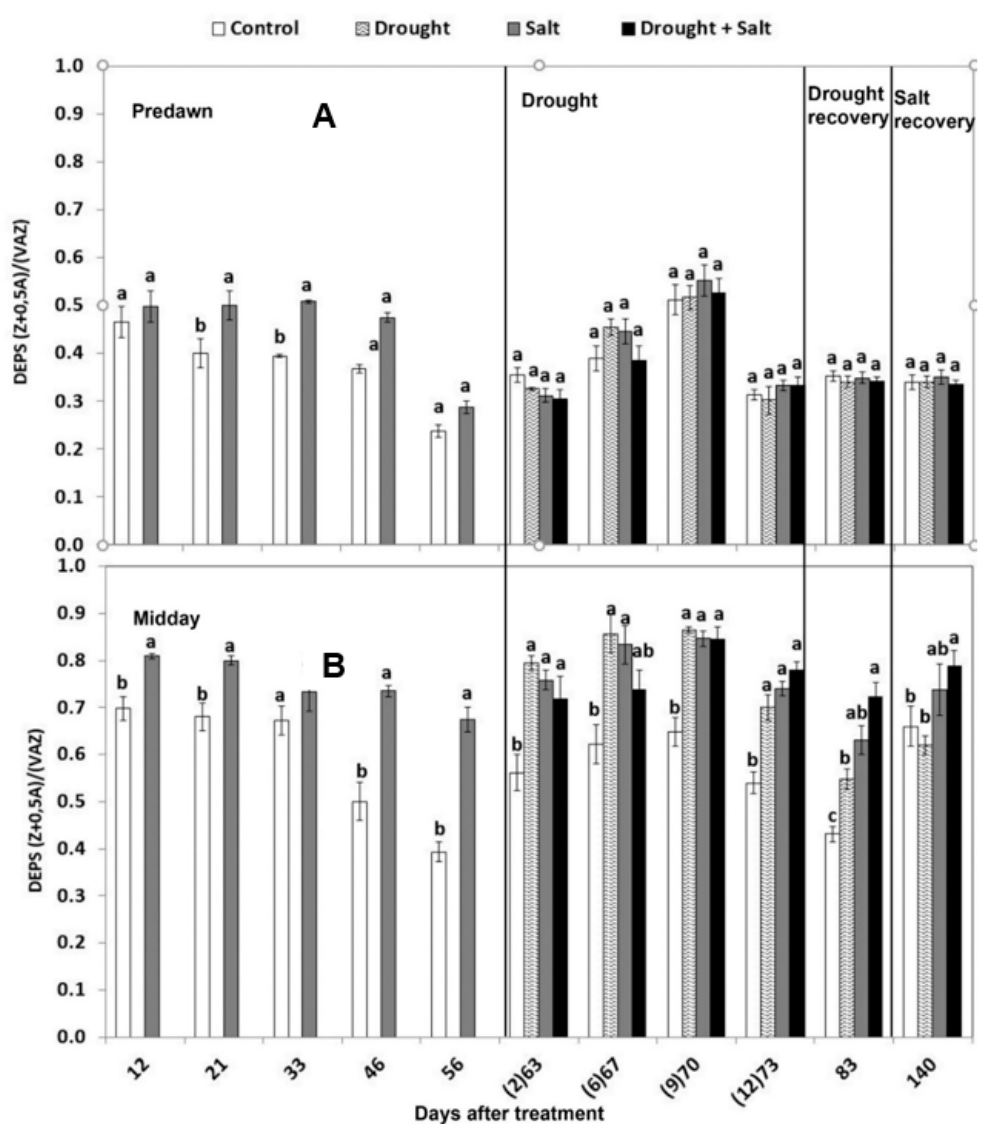
Figure 4. Effect of drought, salt, and the combination of both stresses on de-epoxidation state of the xanthophyll cycles (DEPS) at predawn ( A ) and midday ( B ) of sweetgum plants. The days after drought treatment are reported in brackets. Values per treatment are mean ± SE ( n = 10). Data characterized by the same letter do not differ significantly ( p < 0.05, Tukey’s HSD test).